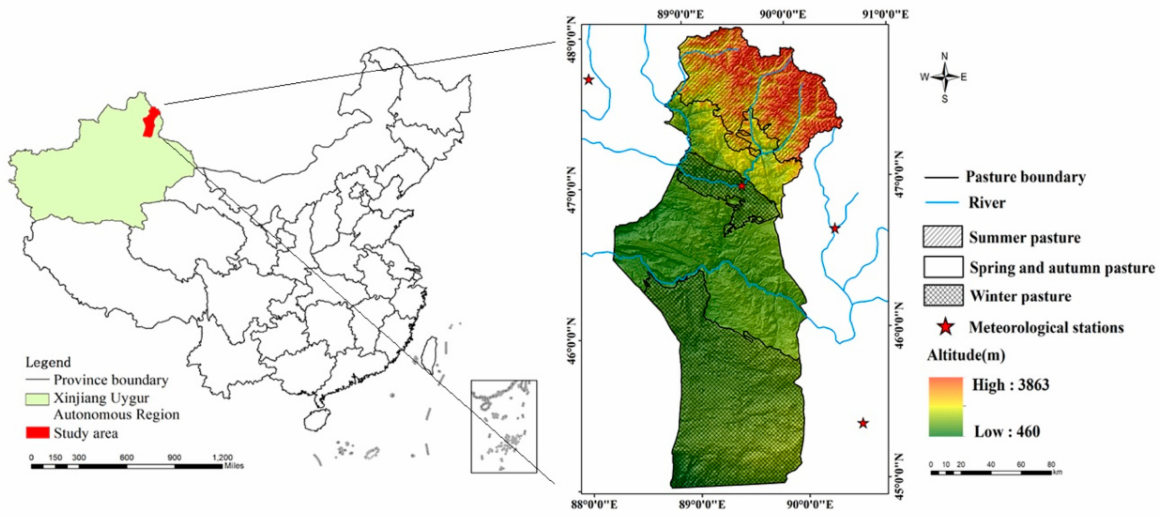
Figure 1. The geographical map of the location of the study